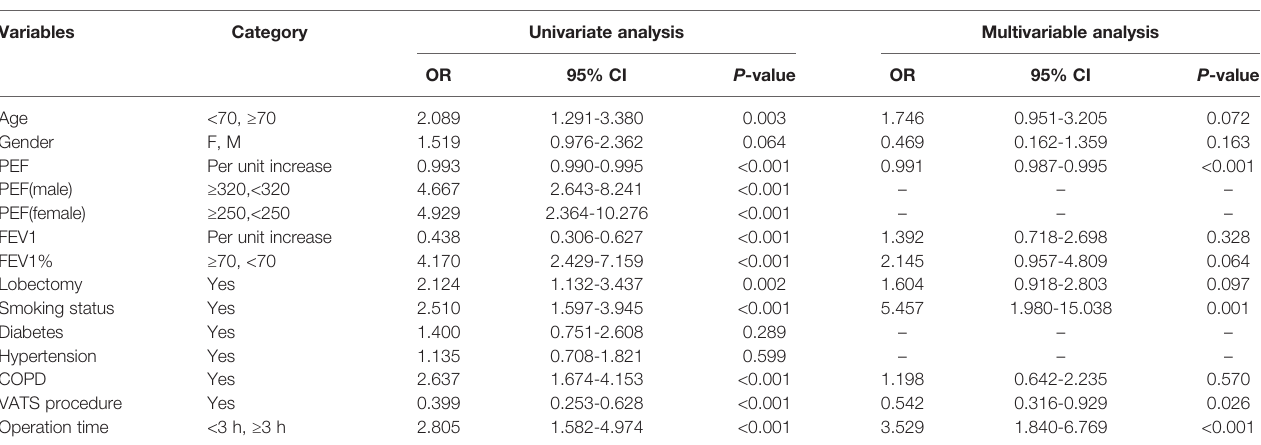
TABLE 2 | Univariate and multivariable analysis for risk factors of PPCs.